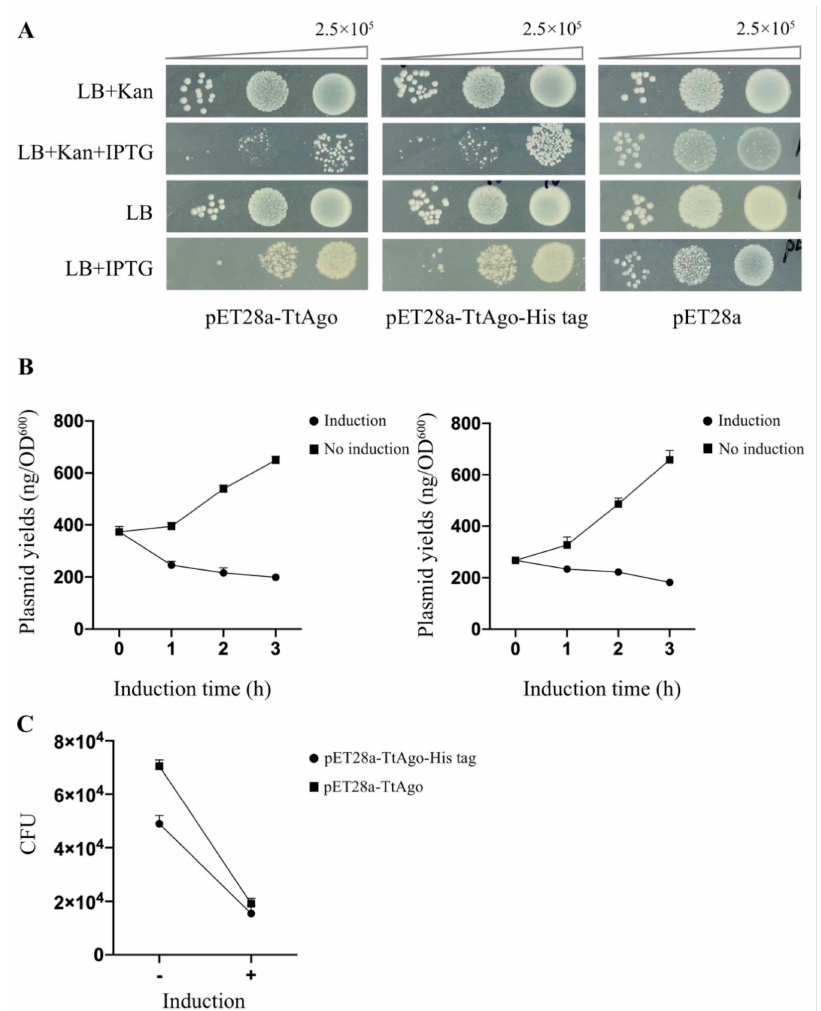
Figure 6. Activity comparison between TtAgo wild type and its 3 (cid:48) terminus modification. ( A ) Spot plating assay for the comparison of pET28a-TtAgo, pET28a-TtAgo-His tag, and pET28a effects on the host cell genome and their expression plasmid yields. Cells were grown with or without IPTG as noted. The upper panels were grown on LB plates supplemented with kanamycin, while the bottom was LB plates without kanamycin. ( B ) Plasmid yields of TtAgo expression vector (pET28a- TtAgo, left vs. pET28a-TtAgo-His tag, right) in BL21 (DE3) at different times post-IPTG induction (means and standard deviations from three biological replicates, error bars represent the mean ± s.d.). ( C ) Colony-forming units were determined after the plasmids recovered from 2-h IPTG induction treatment and no induction treatment were re-transformed into E. coli BL21